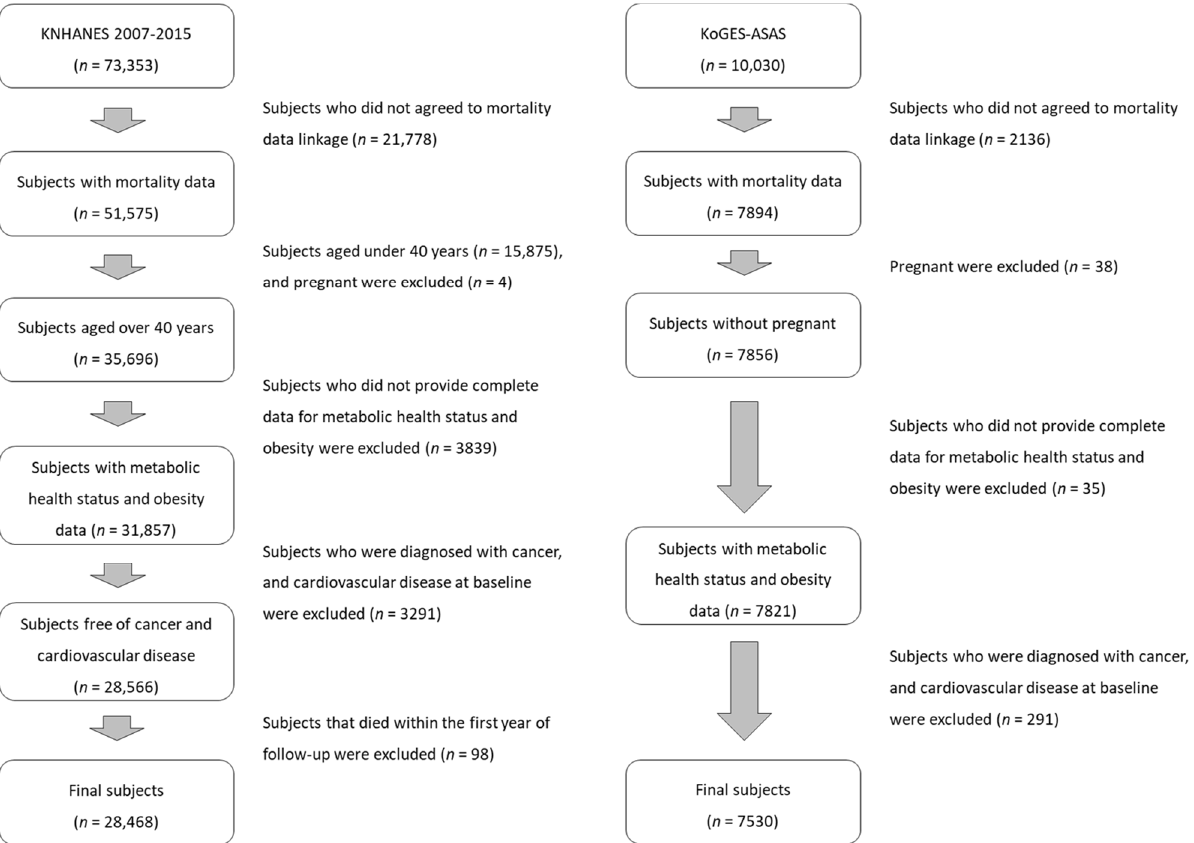
Figure 1. Flow chart of study population.